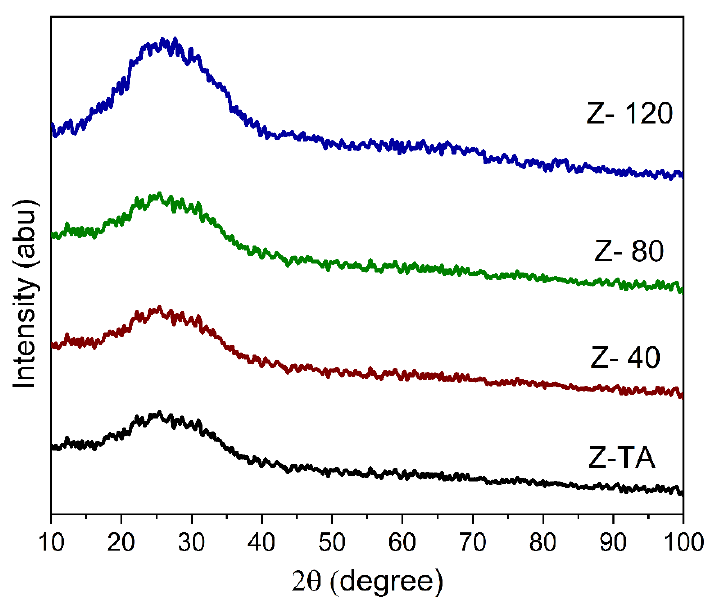
Figure 1. XRD pattern obtained for all the samples show a broad band indicating amorphous phase. No significant change in the structure of ZrO 2 films is observed, whether treated thermally or with UV-A radiation.